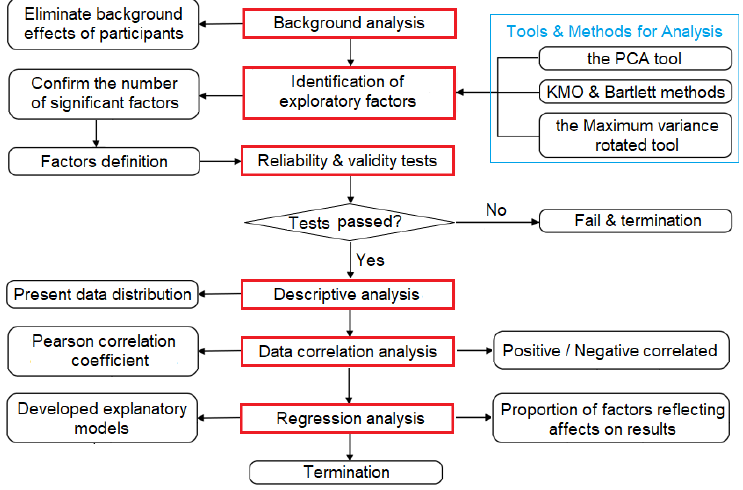
Figure 1. A schematic representation of the noise assessment .